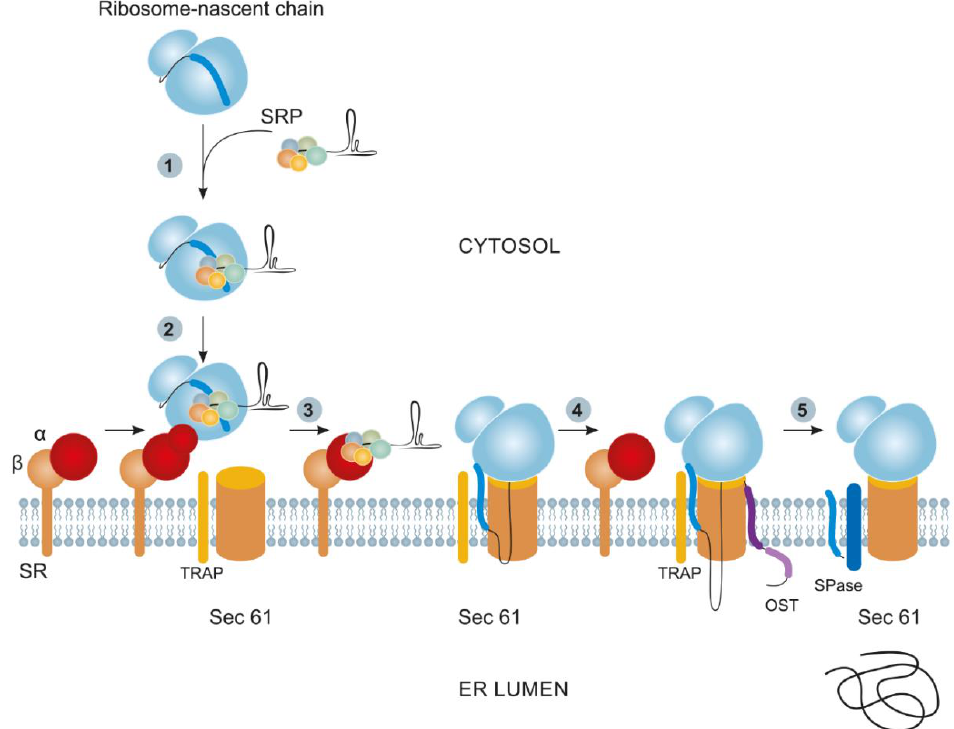
Figure 1. The cotranslational protein targeting pathway: (1) The SRP binds a signal sequence (dark blue) as it emerges from a ribosome to form the RNC–SRP complex; (2) the RNC–SRP complex docks with the ER membrane by binding to a cognate SRP receptor (SR, consisting of α and β subunits); (3) subsequently, the RNC is transferred from SR–SRP to translocon Sec61, resulting in the intercalation of the signal sequence into the translocon pore and its opening; (4) the nascent chain is translocated through the pore, and the SRP disengages from the SR; (5) concomitantly with translocation, the signal peptidase (SPase) and oligosaccharyltransferase (OST) enzyme complexes are recruited to the translocon to cleave the SP and add N-linked glycans to the nascent chain, respectively. The termination of the protein synthesis releases the nascent chain from the ribosome; the translocation is completed; and the protein folds in the ER lumen (adapted from [38] with permission).